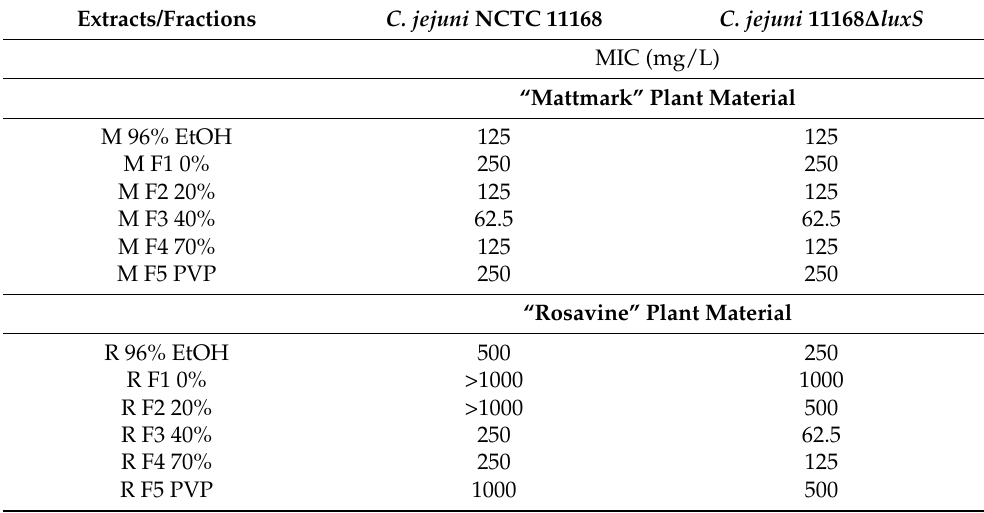
Table 2. Determined MICs of ethanolic extracts and their fractions for C. jejuni NCTC 11168; C. jejuni 11168 ∆ luxS .